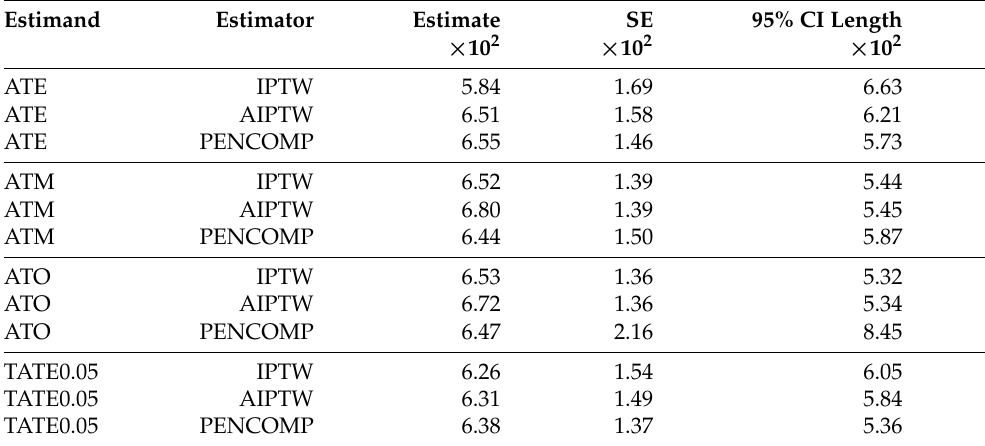
Table 8. RHC dataset: Estimated log odds ratio of death obtained using different methods. Standard errors were calculated based on 1000 bootstrap samples. ATE = Average treatment effect; ATM = av- erage treatment effect on an evenly matchable set; ATO = average treatment effect on the overlap population; TATE α = truncated average treatment effect with a truncation at a pre-defined α